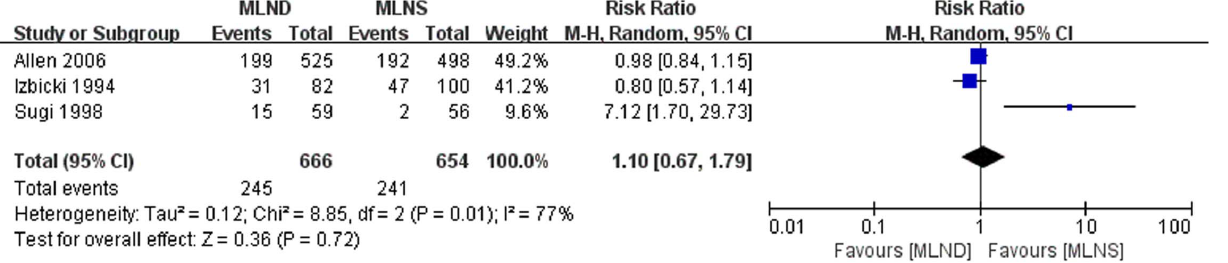
Figure 7. Forest plot of total complications for the MLND vs. MLNS groups. MLND, mediastinal lymph node dissection; MLNS, mediastinal lymph node sampling; RR, risk ratio; CI, confidence